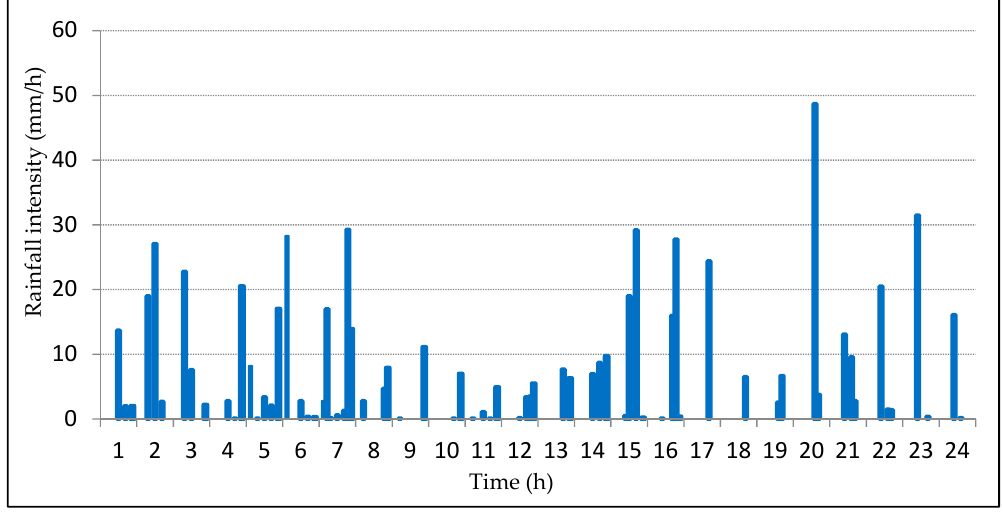
Figure 5. The hourly rainfall with high rainfall intensity for some days in August 2016.